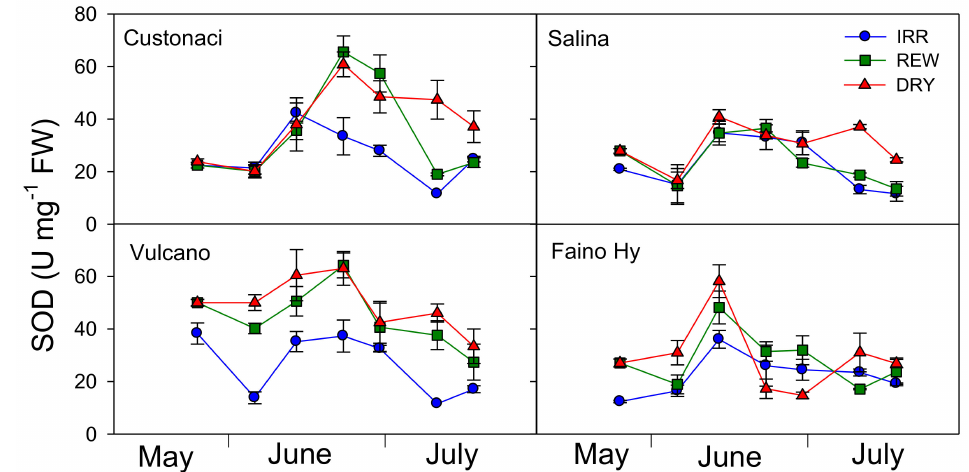
Figure 9. Superoxide dismutase activity (SOD, Units-U mg − 1 FW) in four genotypes of tomato in relation to the irrigation treatment (IRR: full irrigation; REW: rewatering; DRY: no irrigation). Vertical bars indicate the standard error ( n =